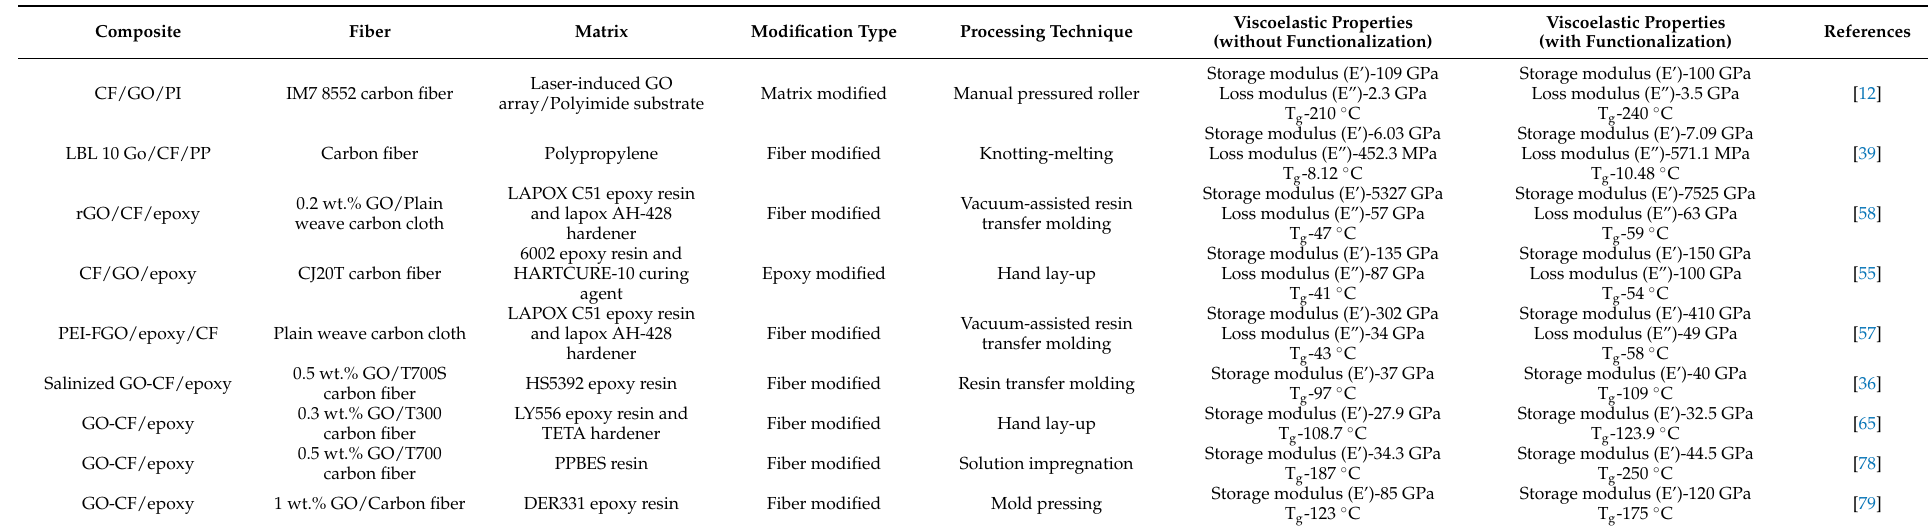
Table 4. Listed viscoelastic properties of CFRPs with